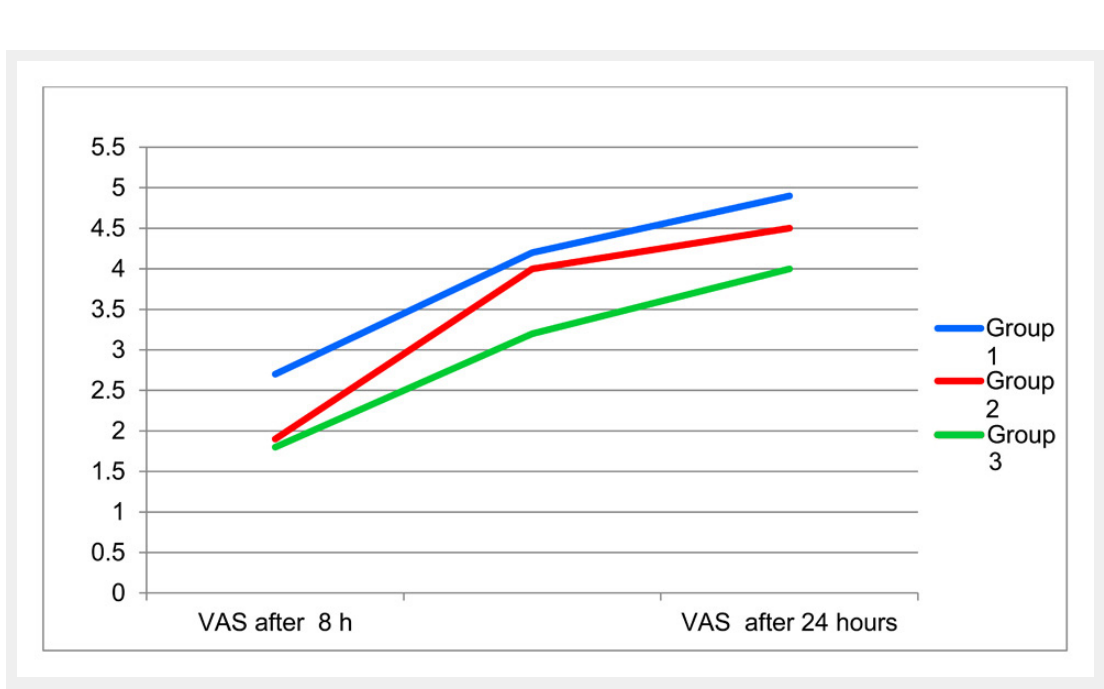
Figure 2 Development of VAS score over time with different catheter